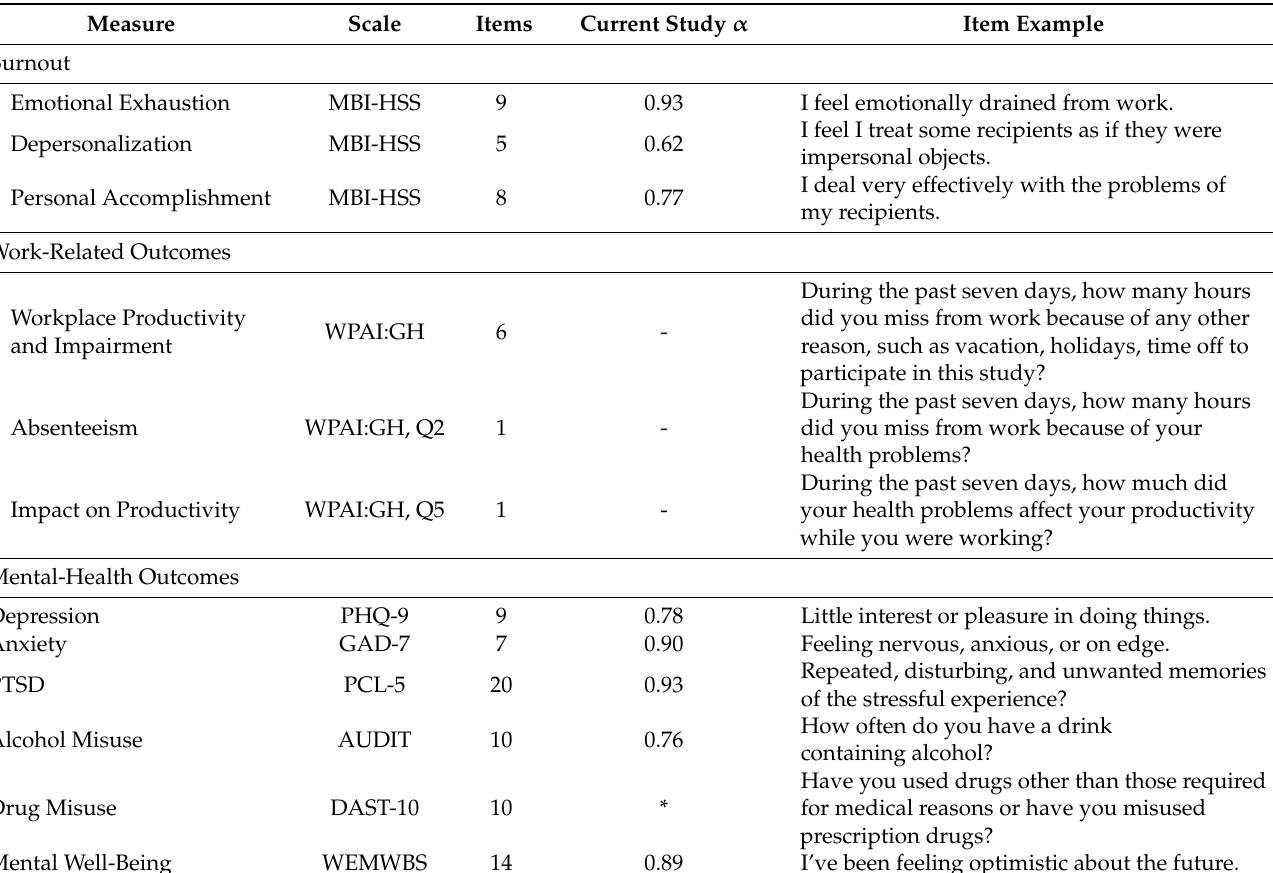
Table 3. Outcome measures